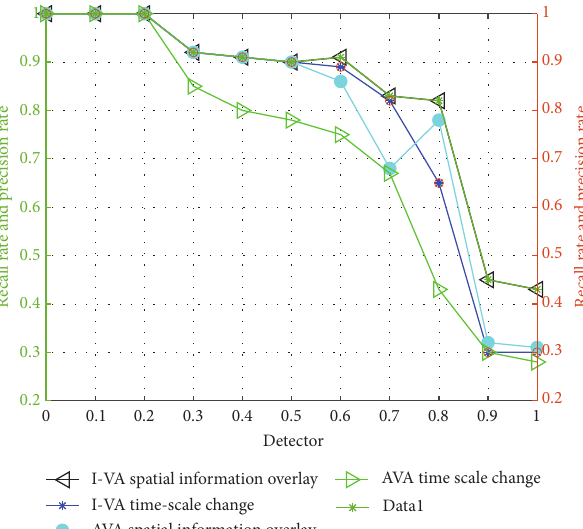
Figure 7: Graph of recall and precision of content-based